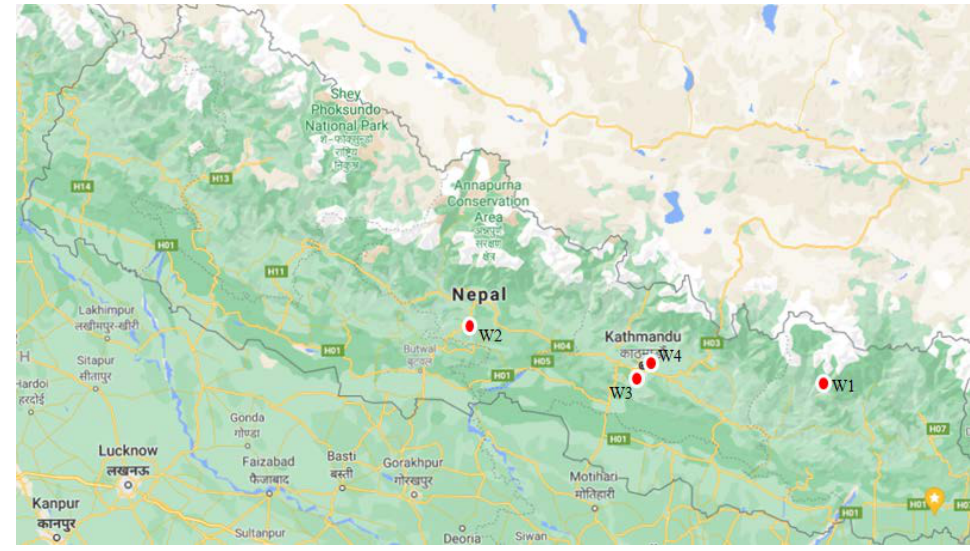
Figure 1. Collection sites of Gaultheria fragrantissima